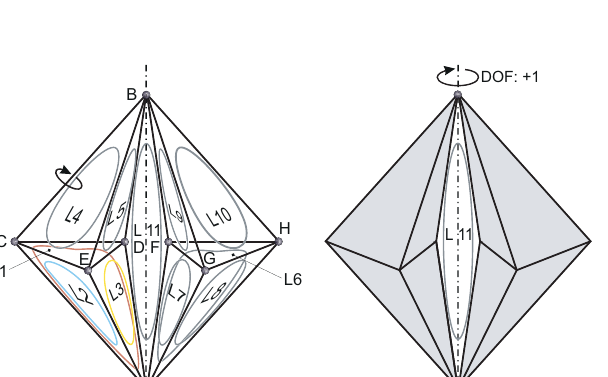
Figure 1. Simple example for an overconstrained mechanism.